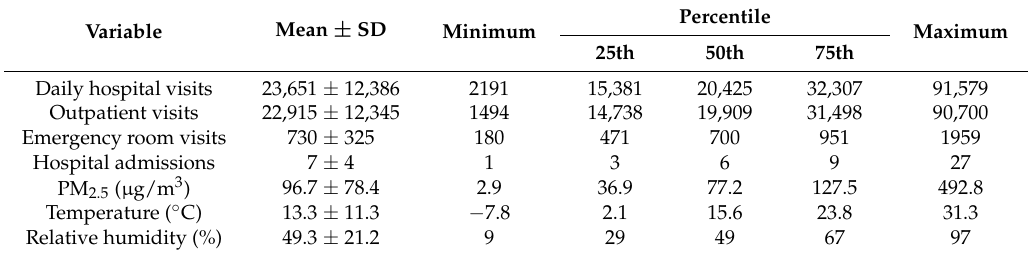
Table 2. Statistical summary of the number of daily hospital visits for URTI, daily fine particulate matter (PM 2.5 ) concentrations, and weather conditions from 10 October 2010 to 30 September 2012 in Beijing, China.